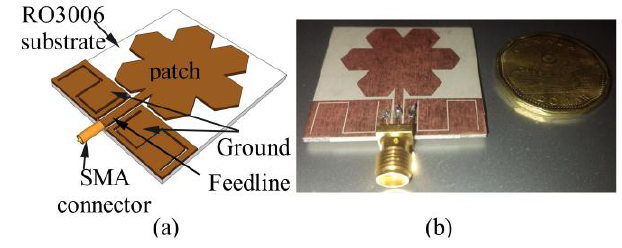
Figure 1: Configuration of the proposed antenna: (a) 3-D view, (b)